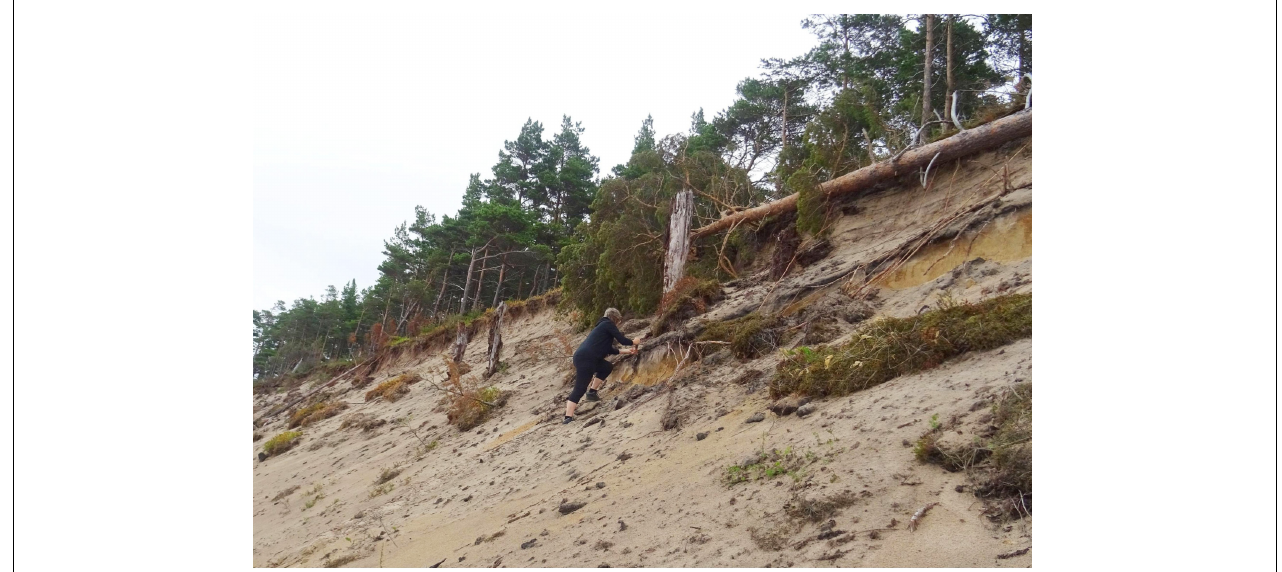
FIGURE 2 | Coastal bluff face at Liepene (stretch 5) with remnants of the trunks of apparently ancient pines (tree group